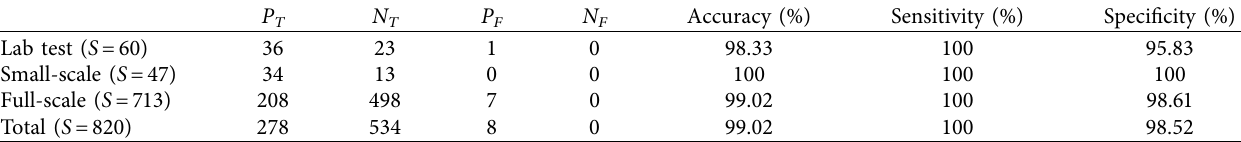
Table 10: The primary technical parameters of this method.